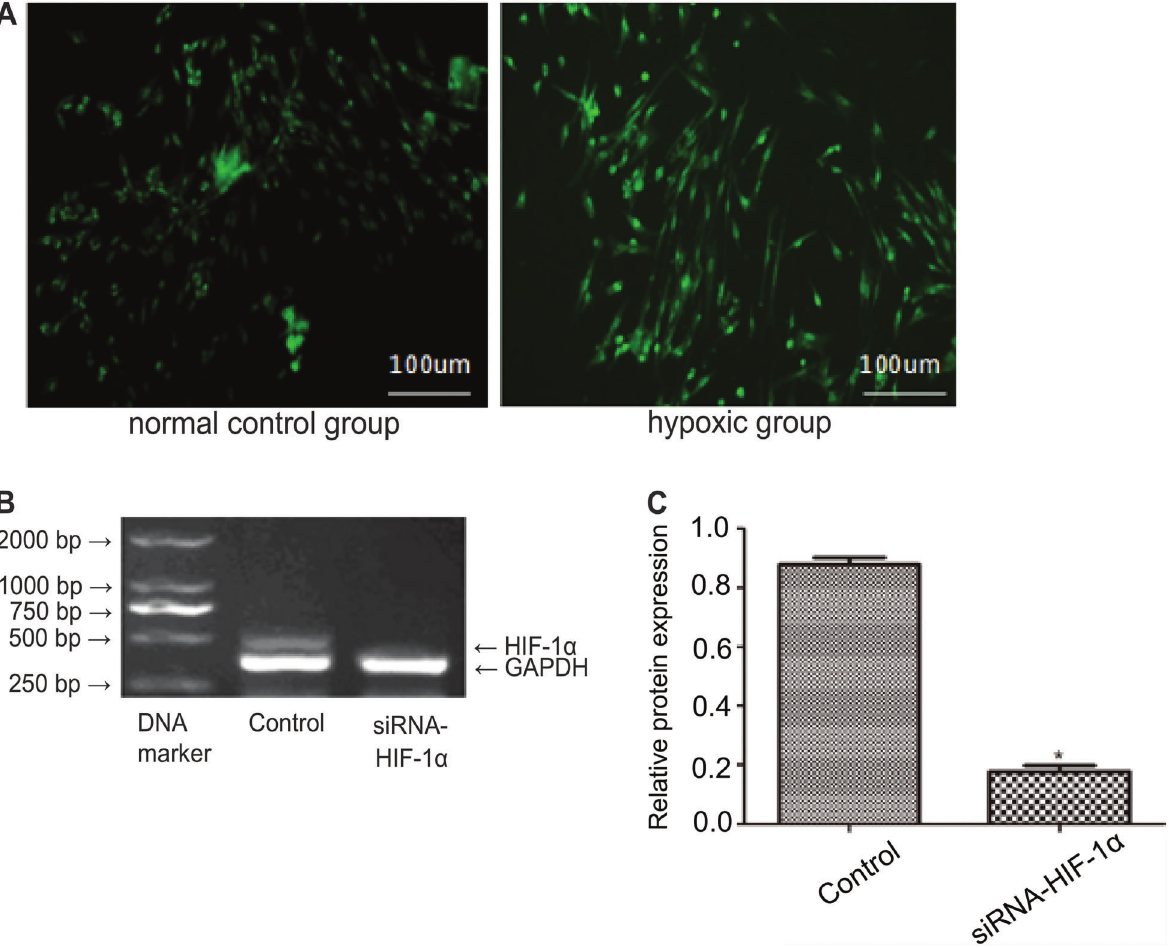
Figure 4. Effects of HIF-1 a RNAi expression vector on VEGF expression and bladder cancer cell permeability. A , Stably transfected HIF-1 a RNAi expression vector in normal control group and hypoxic group. B , HIF-1 a gene expression after stable transfection of HIF-1 a RNAi expression vector pcDNA6.2-GW/EmGFP-miR-siHIF-1 a . C , Histogram of HIF-1 a gene expression after stable transfection of HIF-1 a RNAi expression vector pcDNA6.2-GW/EmGFP-miR-siHIF-1 a . Data are reported as means ± SD. *P o 0.05 compared with normal control group (ANOVA). GADPH: glyceraldehyde 3-phosphate